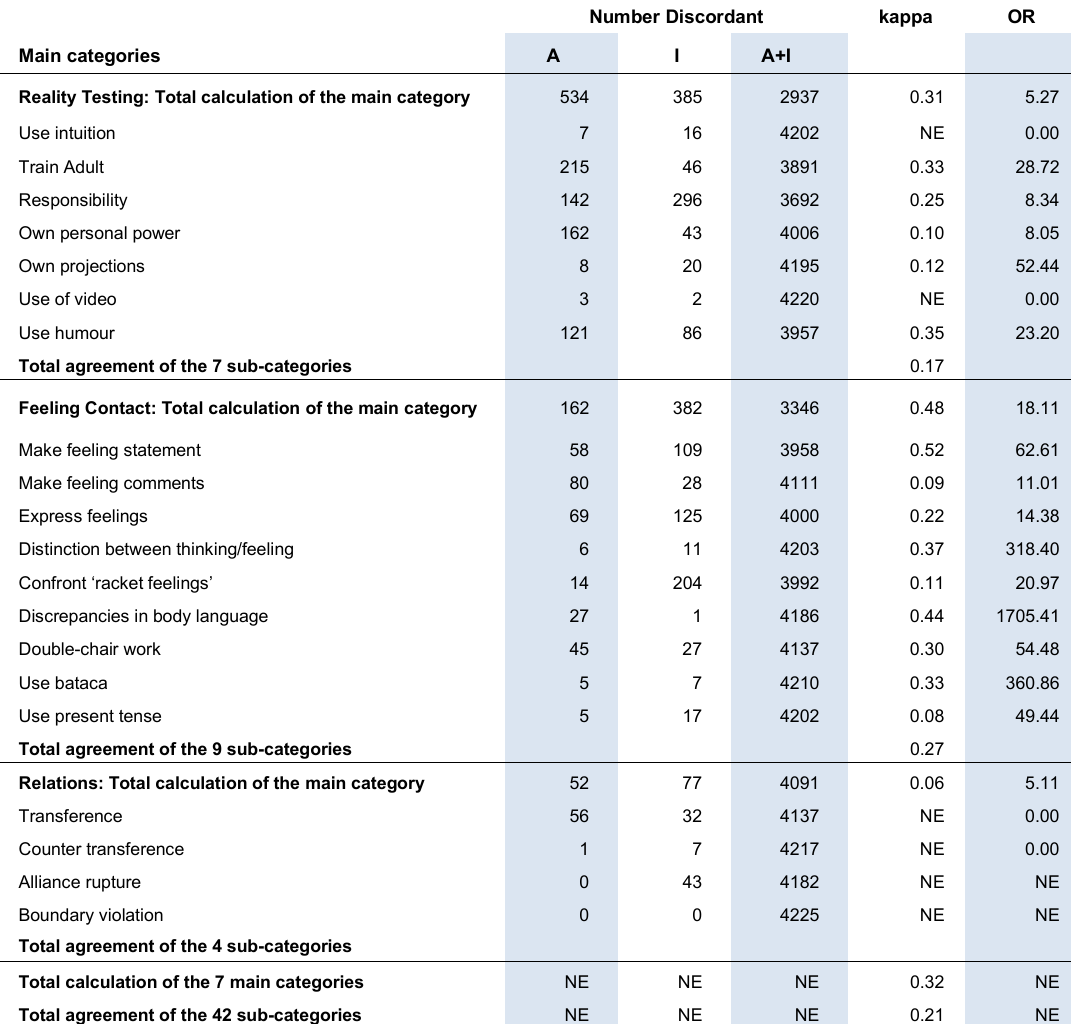
Table 8b: Calculation of kappa quotient (k) and OR quotients (OR) for 3 main categories and 20 sub-categories Number Discordant kappa